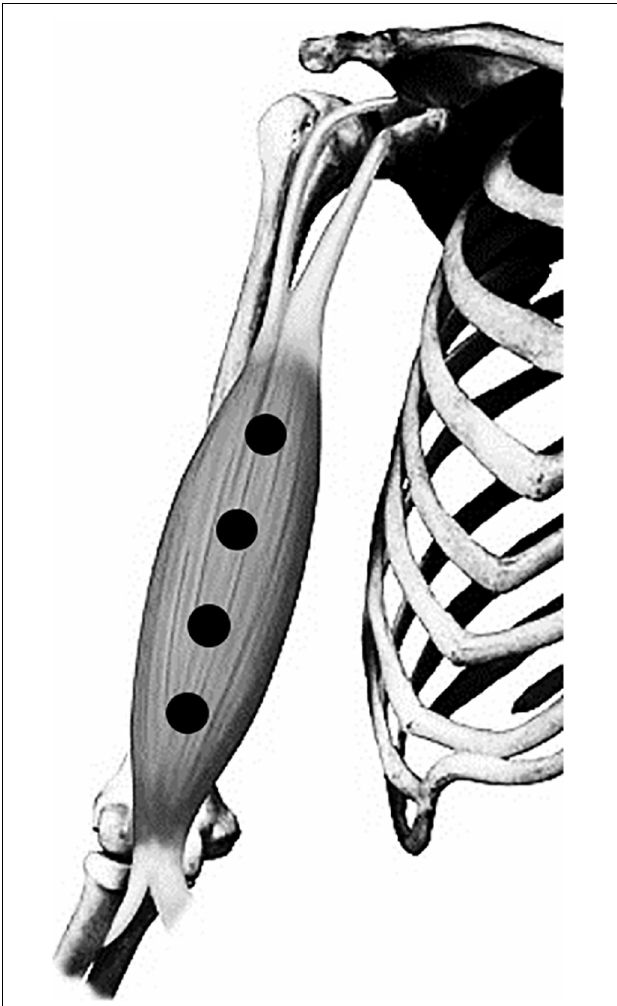
FIGURE 2 | Treatment points (black circles) over biceps brachii